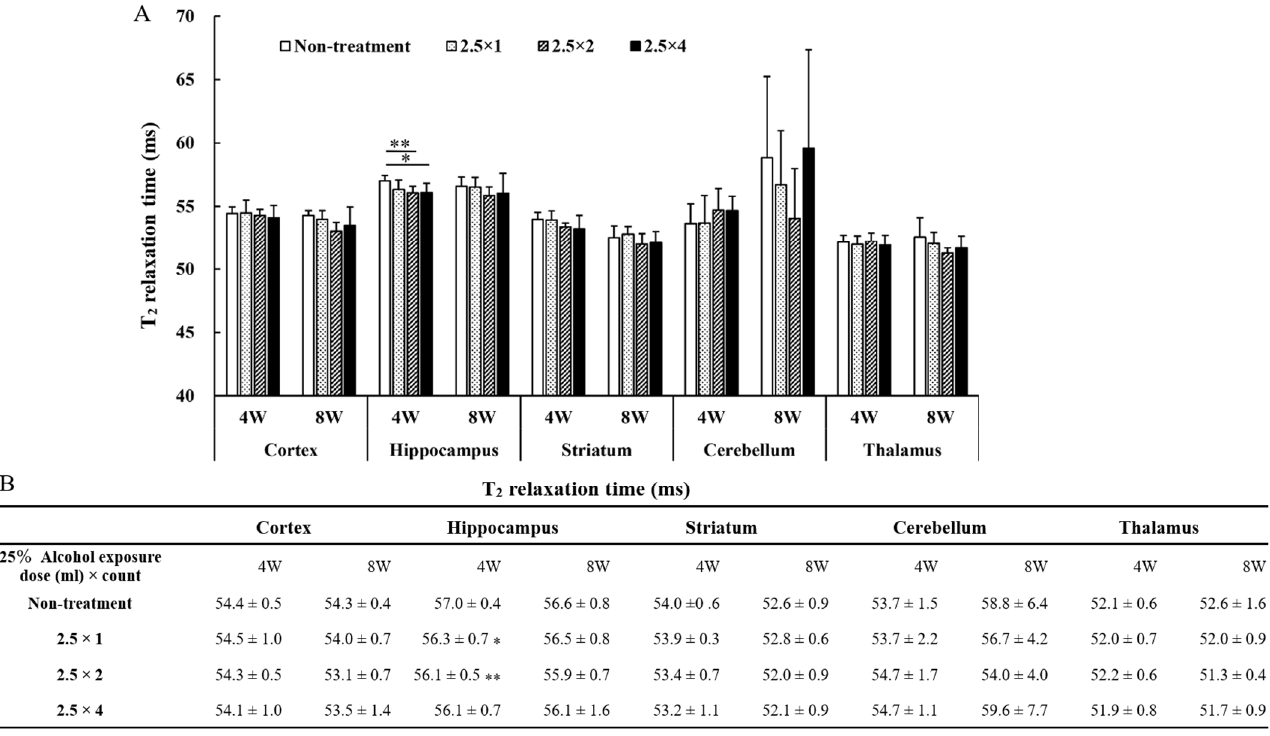
Figure 4. The T 2 values measured in each brain region are shown in graph ( A ) and table ( B ). Between-group comparisons were analyzed by one-way ANOVA with Tukey’s multiple comparison tests using Prism 9. T 2 values were lower in the two- and four-dose groups compared with those of the non-treated group (* p < 0.05, ** p < 0.01). There were no significant differences among the three FASD groups, there was a significant difference only between the non-treatment and the FASD groups (2.5 × 2, 2.5 × 4). Therefore, the FASD group that was significantly different for non-treatment is indicated with an asterisk.